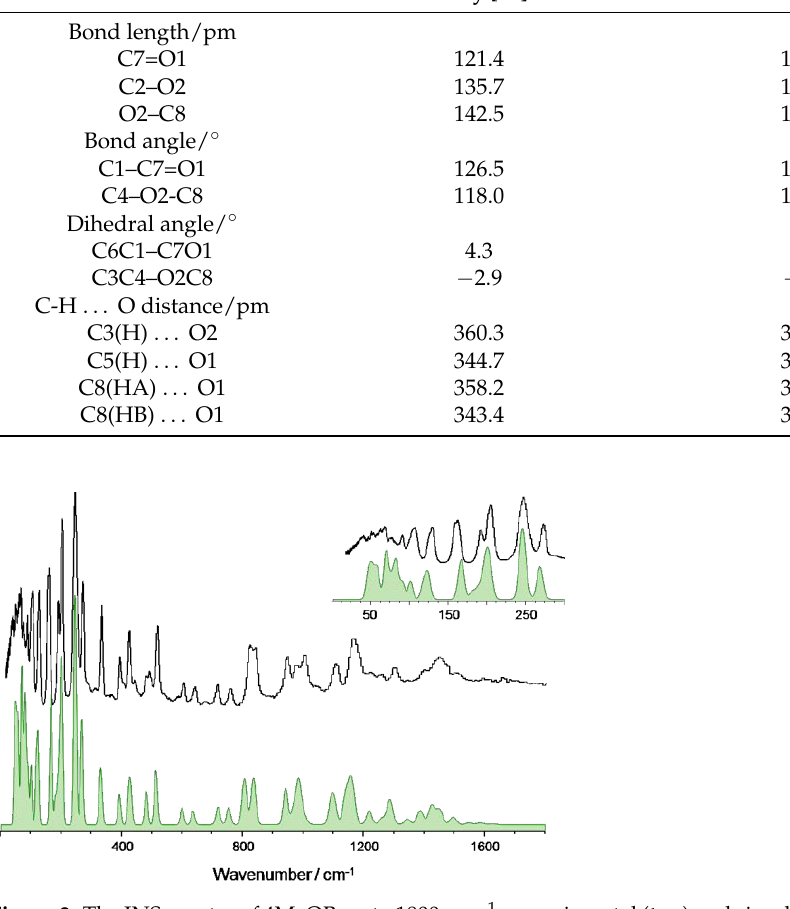
Figure 3. The INS spectra of 4MeOB up to 1800 cm − 1 : experimental ( top ) and simulated from periodic DFT calculations ( bottom , CASTEP). The inset provides a detailed view of the low wavenumber region. The full INS spectra, up to 4000 cm − 1 , and the comparison between periodic and discrete calculations at the same level are shown in Figures S1 and S2, Supplementary Material, respectively.